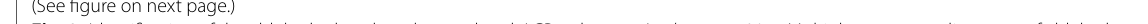
Fig. 2 Identification of the aldehyde decarbonylase and acyl-ACP reductase Anabaena 7120. a Multiple sequence alignment of aldehyde decarbonylase in cyanobacteria. b Multiple sequence alignment of acyl-ACP reductase in cyanobacteria. Anabaena 7120 consists of aldehyde decarbonylase (Alr5283, Accession No. BAB76982) and acyl-ACP reductase (Alr5284, Accession No. BAB76983). Homologs used in the